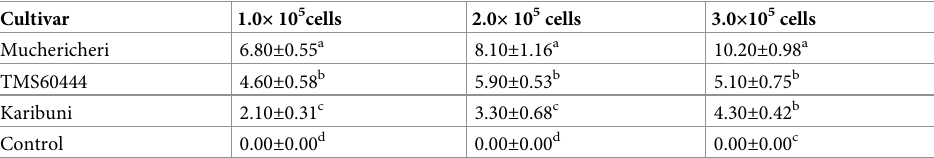
Protoplast cells were cultured on solid media at varying cell densities. Cell colonies was calculated as the number of clumps containing 10 and more cells per clump. Means ( ± SE) followed by different letters in each column are significantly different (P � 0.05) using Fishers